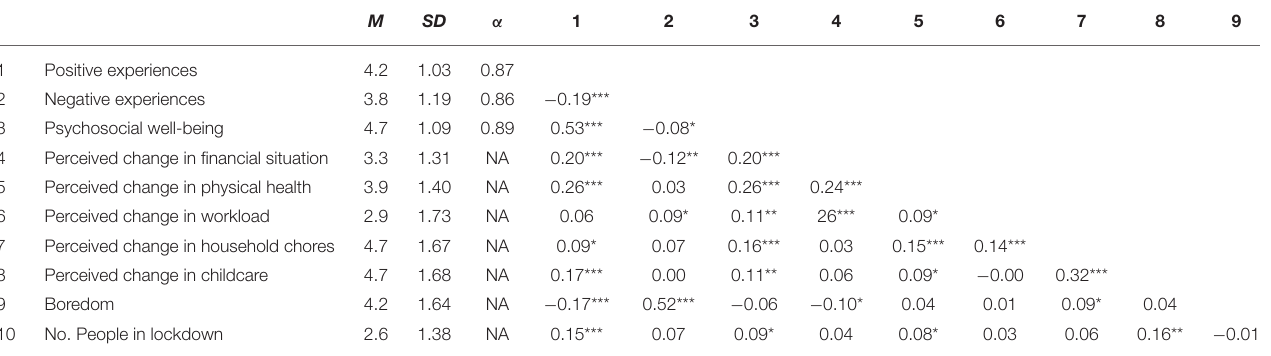
TABLE 1 | Descriptive statistics of the study